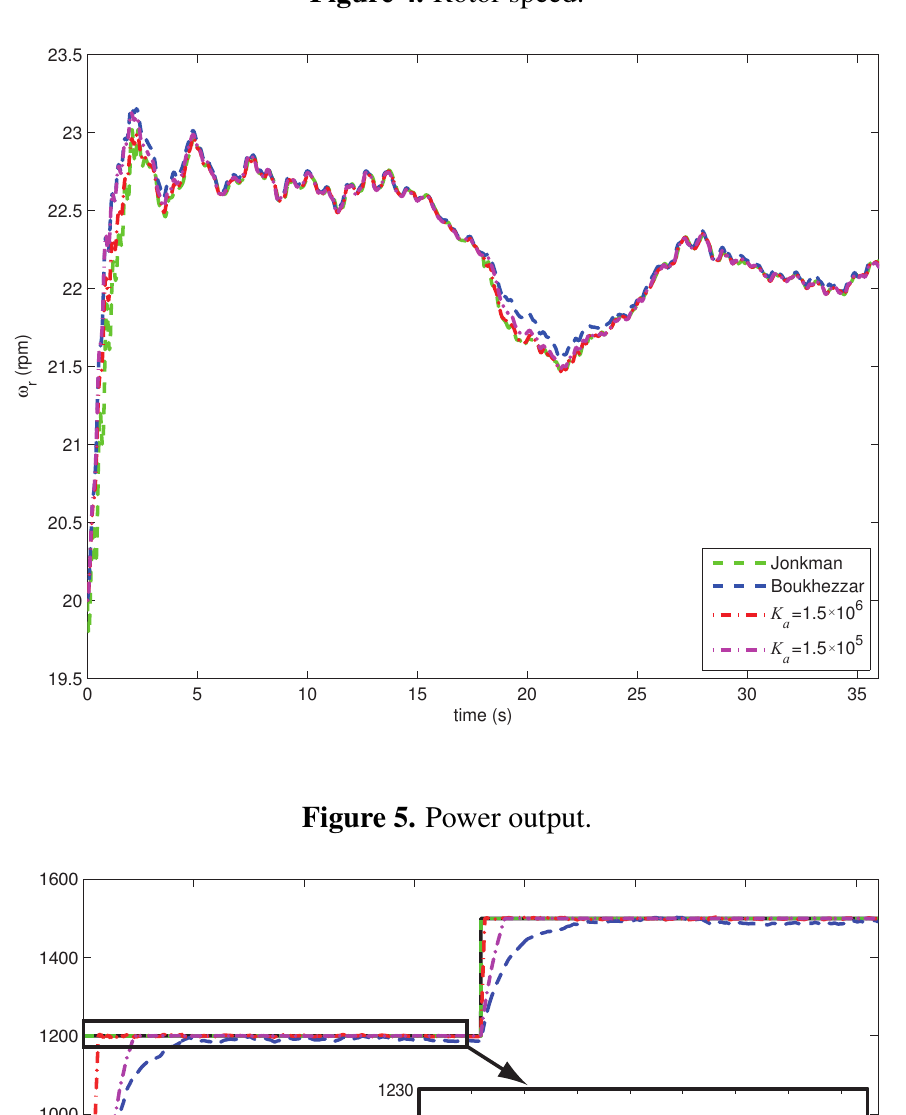
Figure 4. Rotor speed.